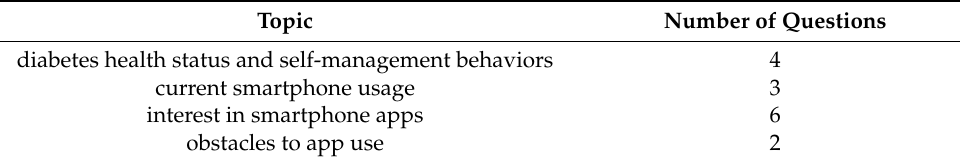
Table 1. Summary of topics covered by the predetermined interview